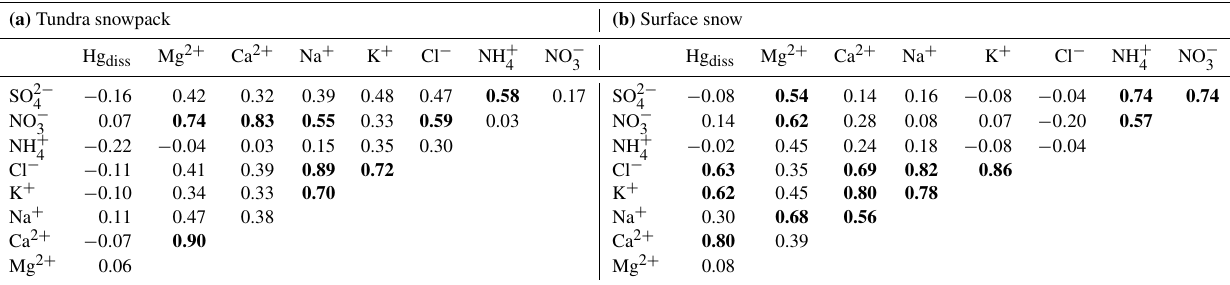
Table 2. Spearman’s coefficient correlations ( ρ , in bold if ≥ 0.5 or ≤− 0.5) between chemical elements (dissolved Hg [Hg diss ] and major ions) in the tundra snowpack (a) and surface snow over the tundra (b)